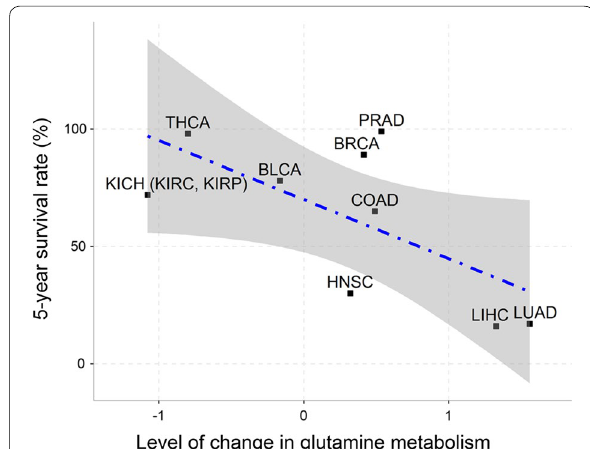
Fig. 2 Significant negative correlation between the increased glutamine metabolism and 5-year survival rate across the 11 types of cancer. The X axis represents the level of change in glutamine metabolism, which is the difference between the levels of glutamine metabolism in cancer versus control tissues; the Y axis represents the 5-year survival rate of cancer. The average level of change in glu- tamine metabolism across three subtypes of the kidney cancer (KICH, KIRC, and KIRP) is used because there are no 5-year survival data for the individual subtypes. BLCA, bladder urothelial carcinoma; BRCA, breast invasive carcinoma; COAD, colon adenocarcinoma; HNSC, head and neck squamous cell carcinoma; KICH, kidney chromophobe; KIRC, kidney renal clear cell carcinoma; KIRP, kidney renal papillary cell car- cinoma; LIHC, liver hepatocellular carcinoma; LUAD, lung adenocarci- noma; PRAD, prostate adenocarcinoma; THCA, thyroid carcinoma